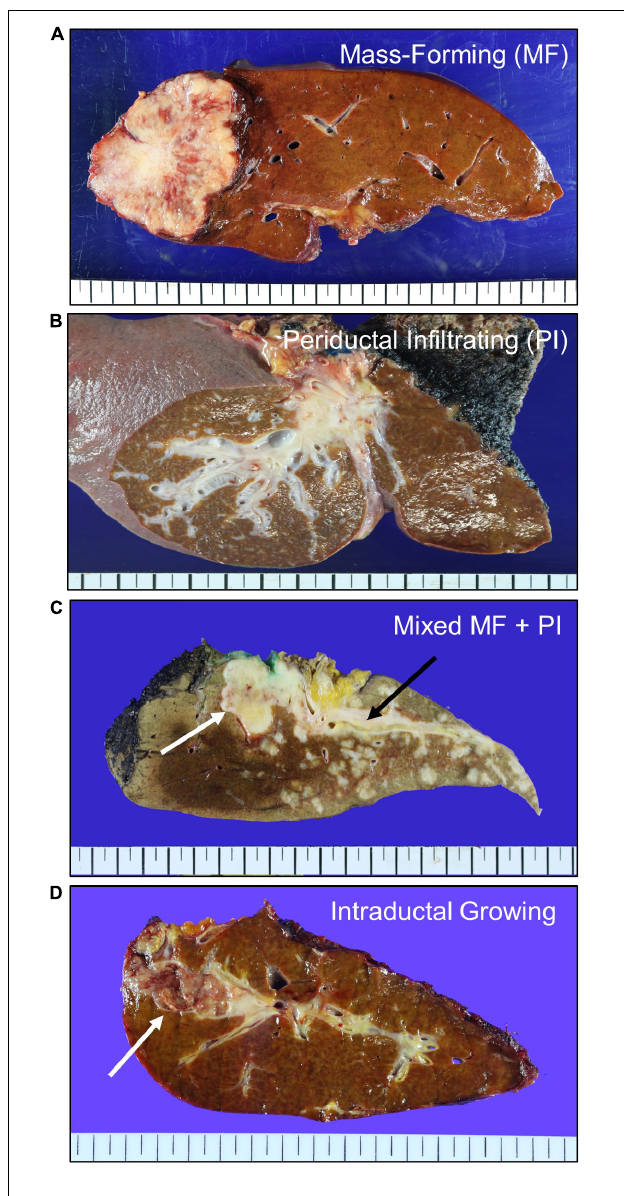
FIGURE 1 | Macroscopic types of intrahepatic cholangiocarcinoma. (A) Mass-forming (MF) type showing a whitish tan tumor mass invading adjacent liver parenchyma. (B) Periductal infiltrating (PI) type showing a whitish periductal tumor growth along the bile duct branches. (C) Mixed type of MF and PI showing a solid tumor of MF type (white arrow) and a periductal growth of PI type (black arrow). (D) Intraductal growing type showing a friable tumor mass in the dilated bile duct (white arrow). This type of tumor is re-classified as intraductal papillary neoplasm of bile